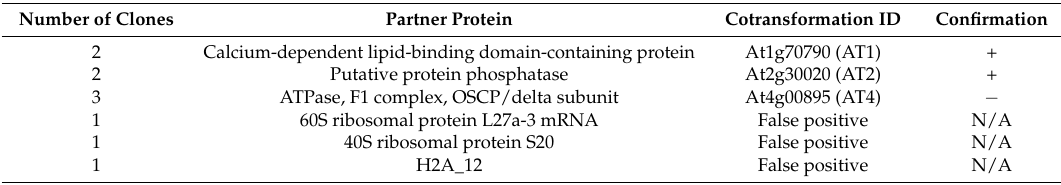
Table 1. Selected partner proteins for